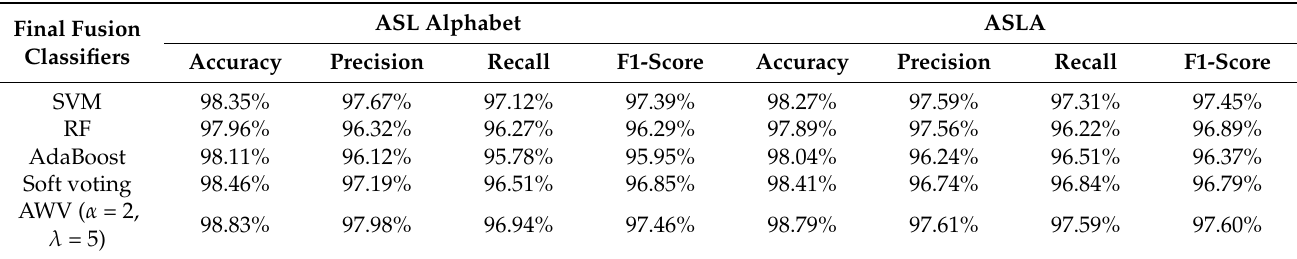
Table 7. Performance evaluation of five classifiers on two datasets.